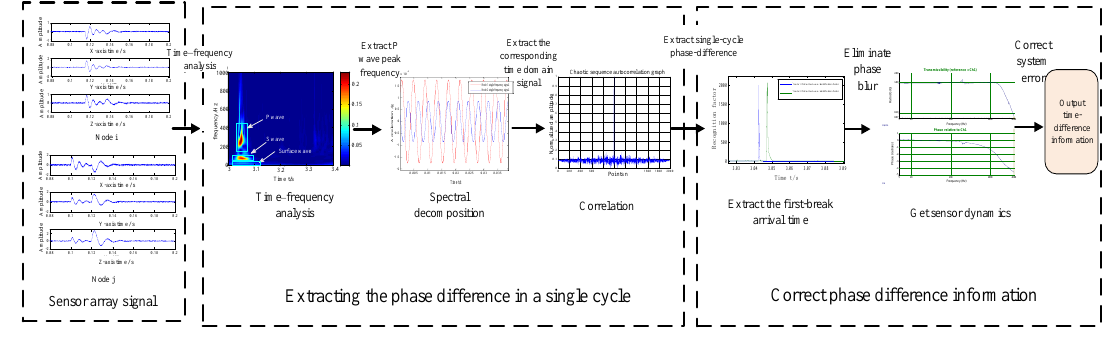
Figure 2. Flow chart of time-difference extraction.